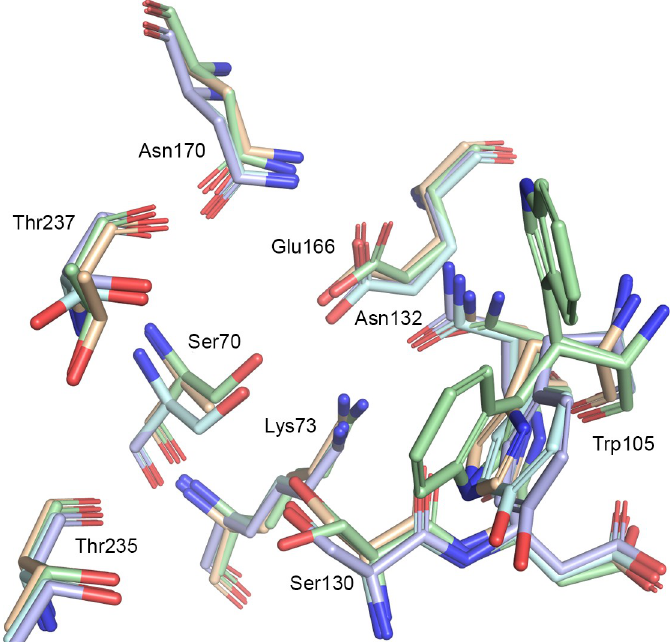
Fig 7. Analysis of PoSSuM hits. Superposition of the Kp KPC-2 binding site residues (PDB code 3RXW, green) with the E . coli CTX-M-9 β -lactamase (PDB code 4DDS, blue), the S . fonticola SFC-1 β -lactamase (PDB code 4EUZ, beige) and the E . coli TOHO-1 β -lactamase (PDB code 4BD0, cyan) (Ambler numbering)